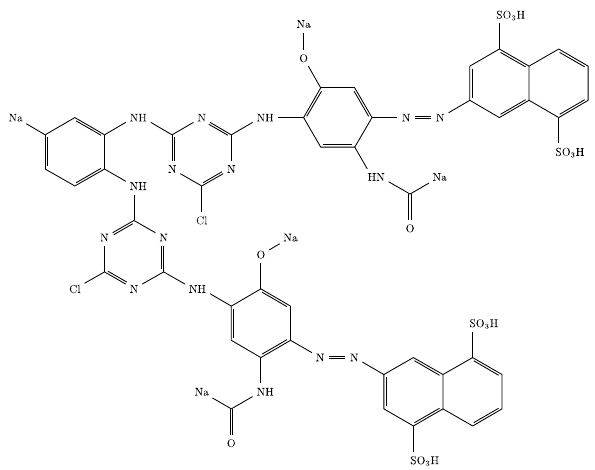
Figure 13. Chemical structure CAS No. 72916-24-2.